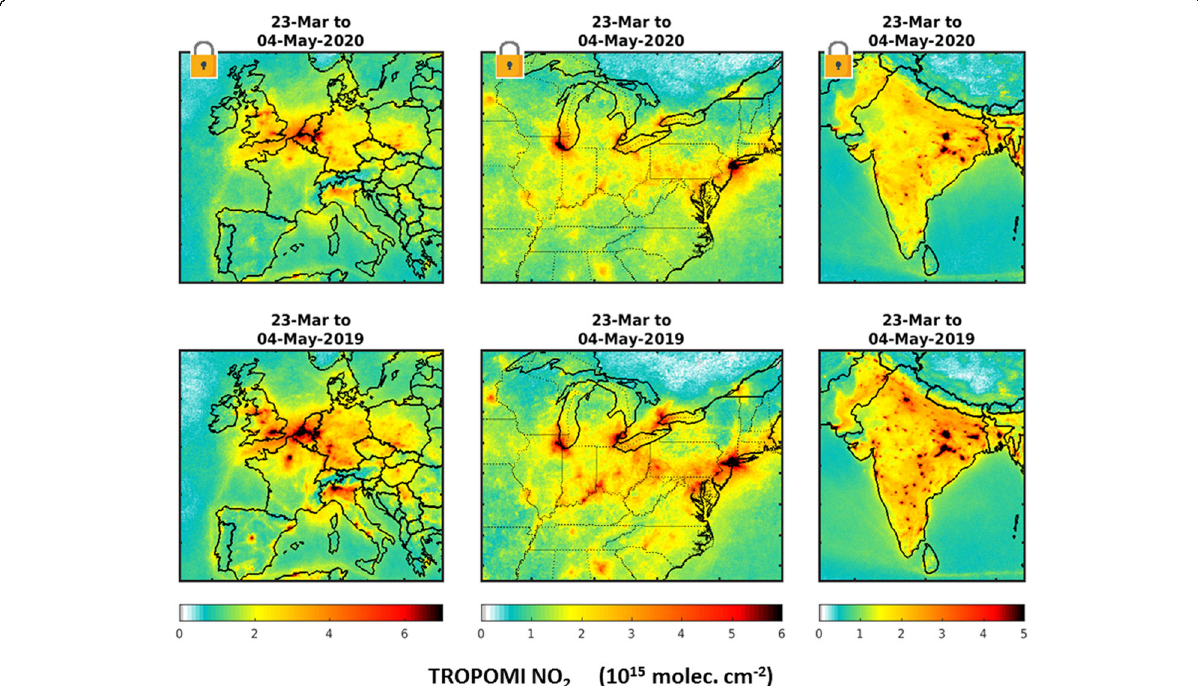
Fig. 11 TROPOMI (S-5P) data showing changes observed in tropospheric NO 2 over urban areas during the COVID-19 outbreak compared to the same period in the previous year. (From: the Royal Belgian Institute for Sapce Aeronomy (BIRA-IASB), in collaboration with the Royal Netherlands Meteorological Institute (KNMI) and the European Space Agency.https://www.aeronomie.be/en, then clicking on: "Satellites see a worldwide decrease in nitrogen dioxide pollution as a result of the COVID-19 crisis, China shows first signs of economic recovery''. Modified S-5P data, press release after Bauwens et al. 2020 was published on May